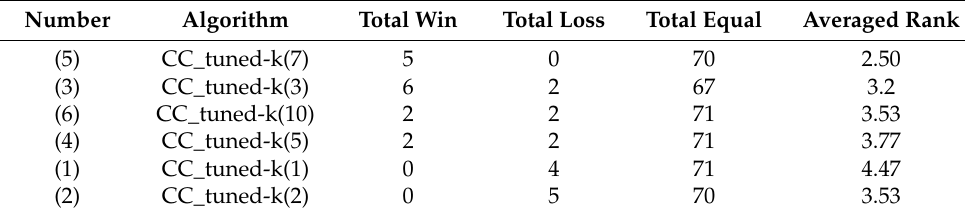
Table 7. The sum of the Wilcoxon test results.